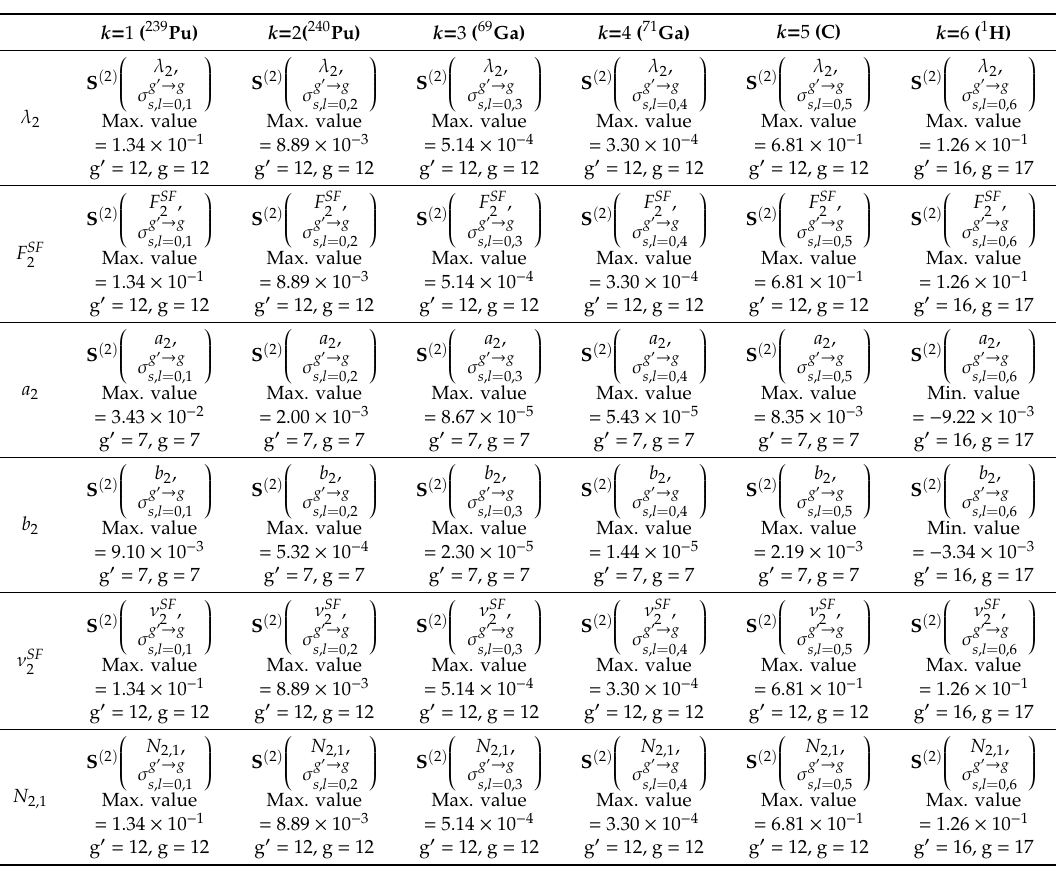
Table 10. Summary presentation of the matrix S ( 2 ) the leakage response with respect to the source parameters of isotope 240 Pu and the 0th-order ( l = 0 ) scattering cross sections for all isotopes in the PERP